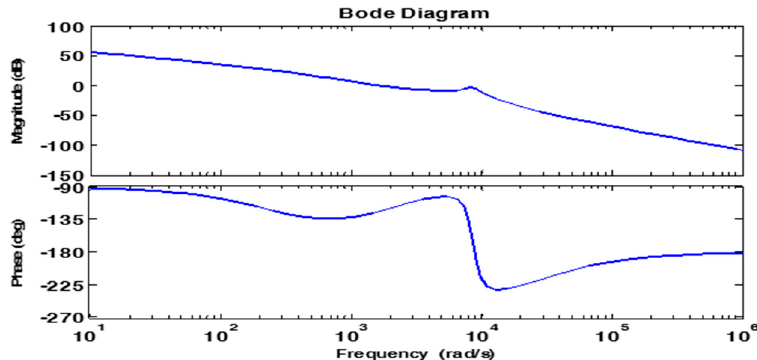
Figure 12. Block Diagram of two degrees of freedom controller.